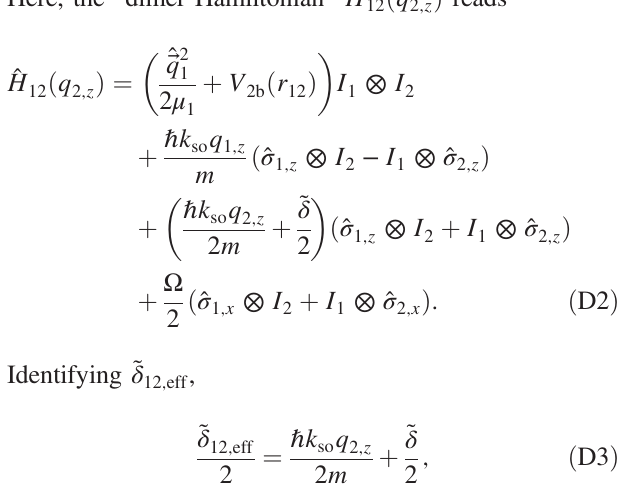
Þ − 1 ¼ k s so of the atom- ad ;z